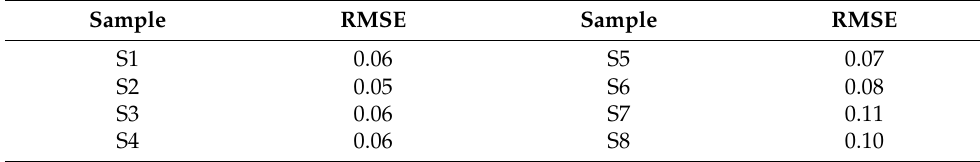
Table 7. RMSE for each sample of woven fabrics. Sample RMSE